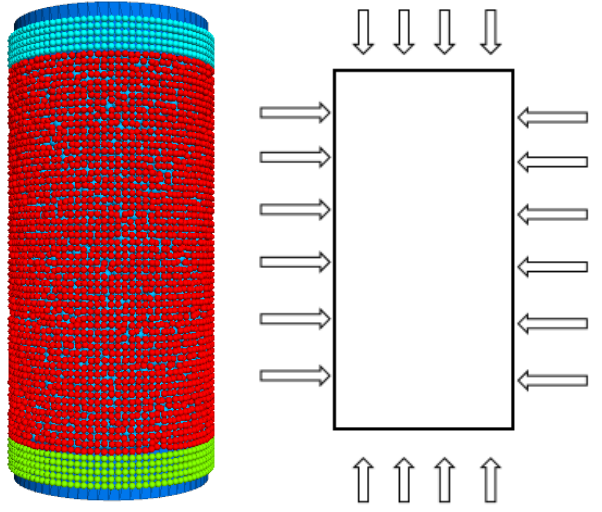
Figure 3. Numerical simulation of uniaxial compression. Figure 4. Triaxial numerical simulation